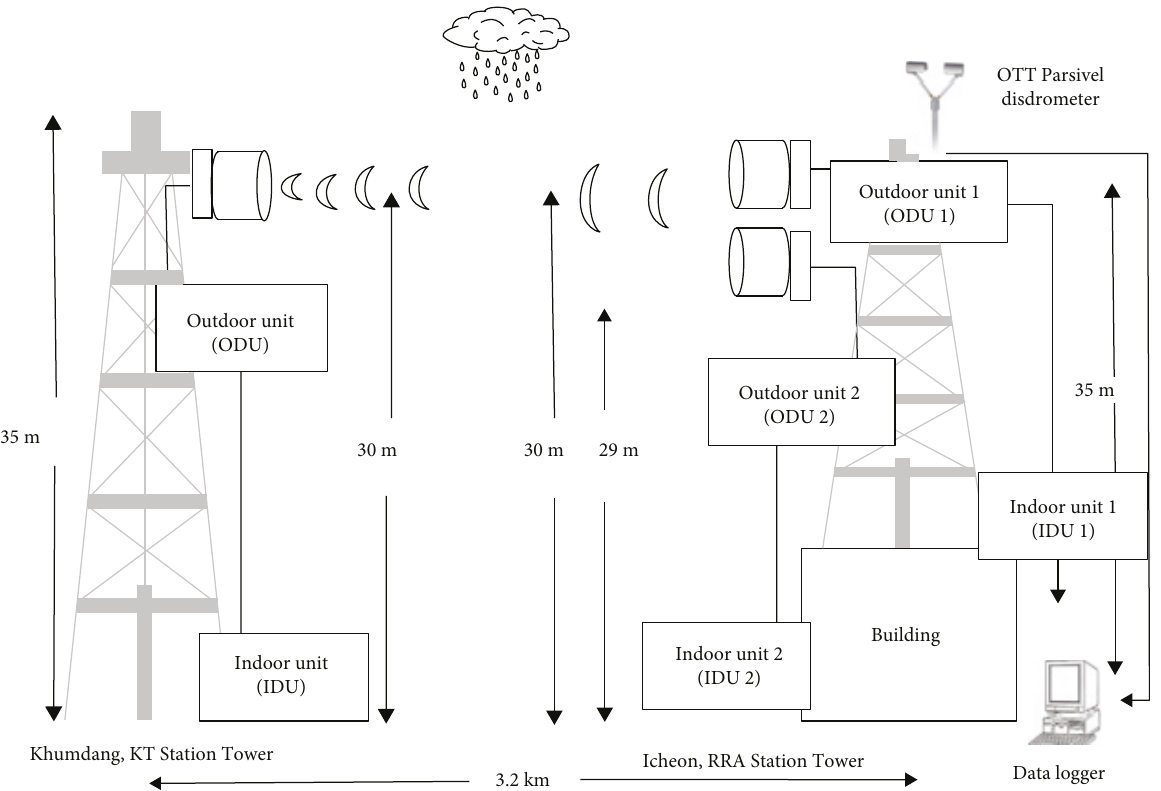
Figure 1: Experimental setup for rain attenuation and rain rate measurement